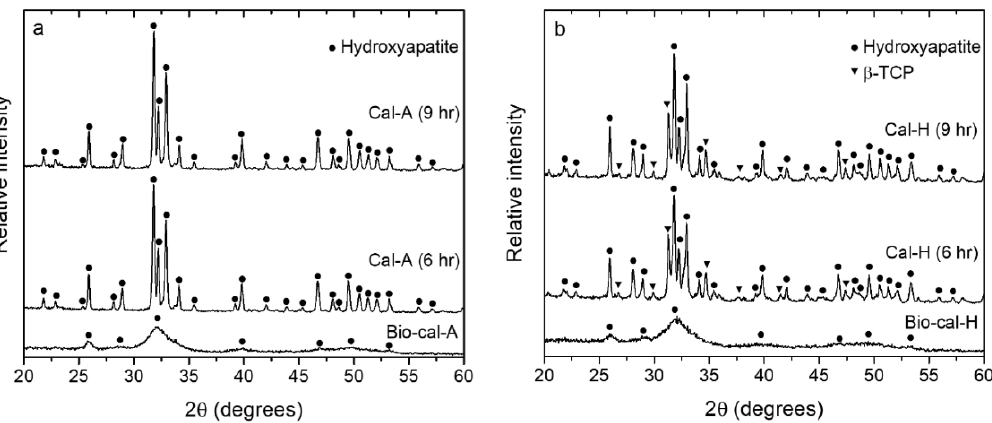
Figure 3. X-ray di ff raction patterns of bio-calcium and 900 ◦ C-calcined bone powders at 6 and 9 h with Figure 3. X-ray diffraction patterns of bio-calcium and 900 °C-calcined bone powders at 6 and 9 h with alkaline treatment ( a ) and without alkaline treatment ( b alkaline treatment ( a ) and without alkaline treatment ( b ).